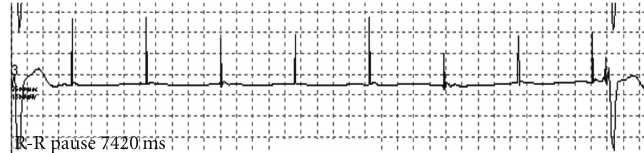
Figure 2: Holter recording showing only atrial pacing spikes without ventricular response resulting in a pause of 7.4